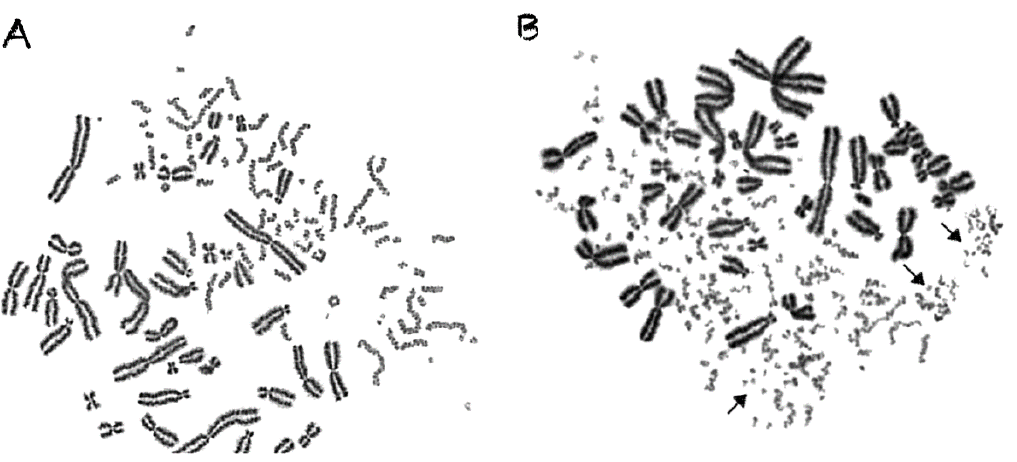
Figure 4. Following exposure to different radiation qualities, persistent shattered chromosome domains can be visualized and quantified in G0 lymphocyte PCC spreads. ( A ) Ring formation and a reduction in the number of excess PCC breaks may be observed at 24 h post-irradiation repair time at 37 °C, following exposure to 6 Gy of α -particles. ( B ) Under the same conditions, however, most of the irradiated lymphocytes still exhibit a high number of excess PCC fragments and shattered chromosome domains after 24 h of repair, as shown by arrows.